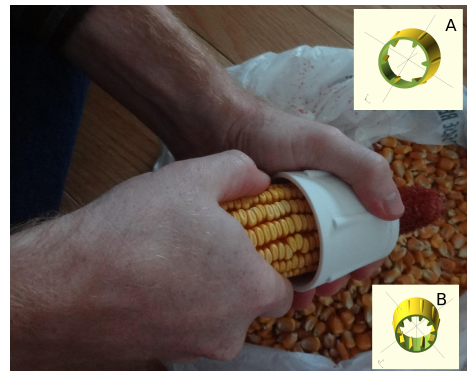
Figure 9. Corn being shelled with a 3-D printable corn sheller. Insets A and B demonstrate the ability to cus- tomize the OpenSCAD code to print corn shellers for dif- ferent types of maize.